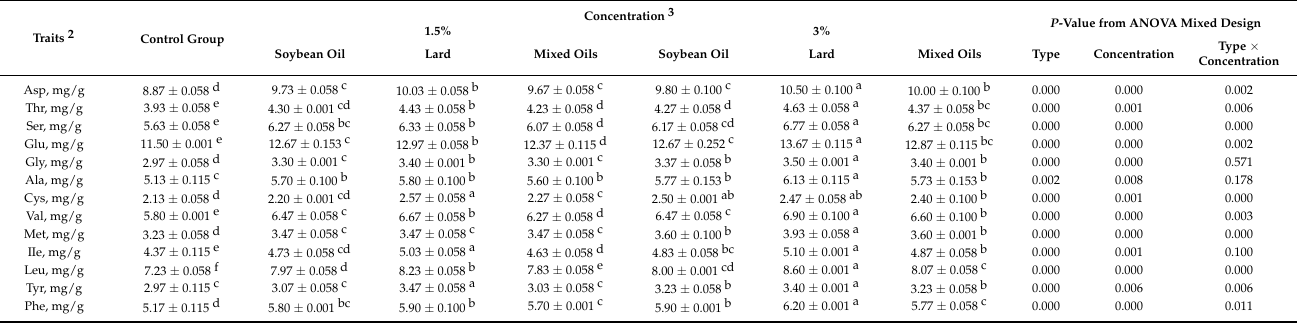
Table 7. Effects of different concentrations of soybean oil, lard, and mixed oils on amino acids, protein, and moisture of albumen 1